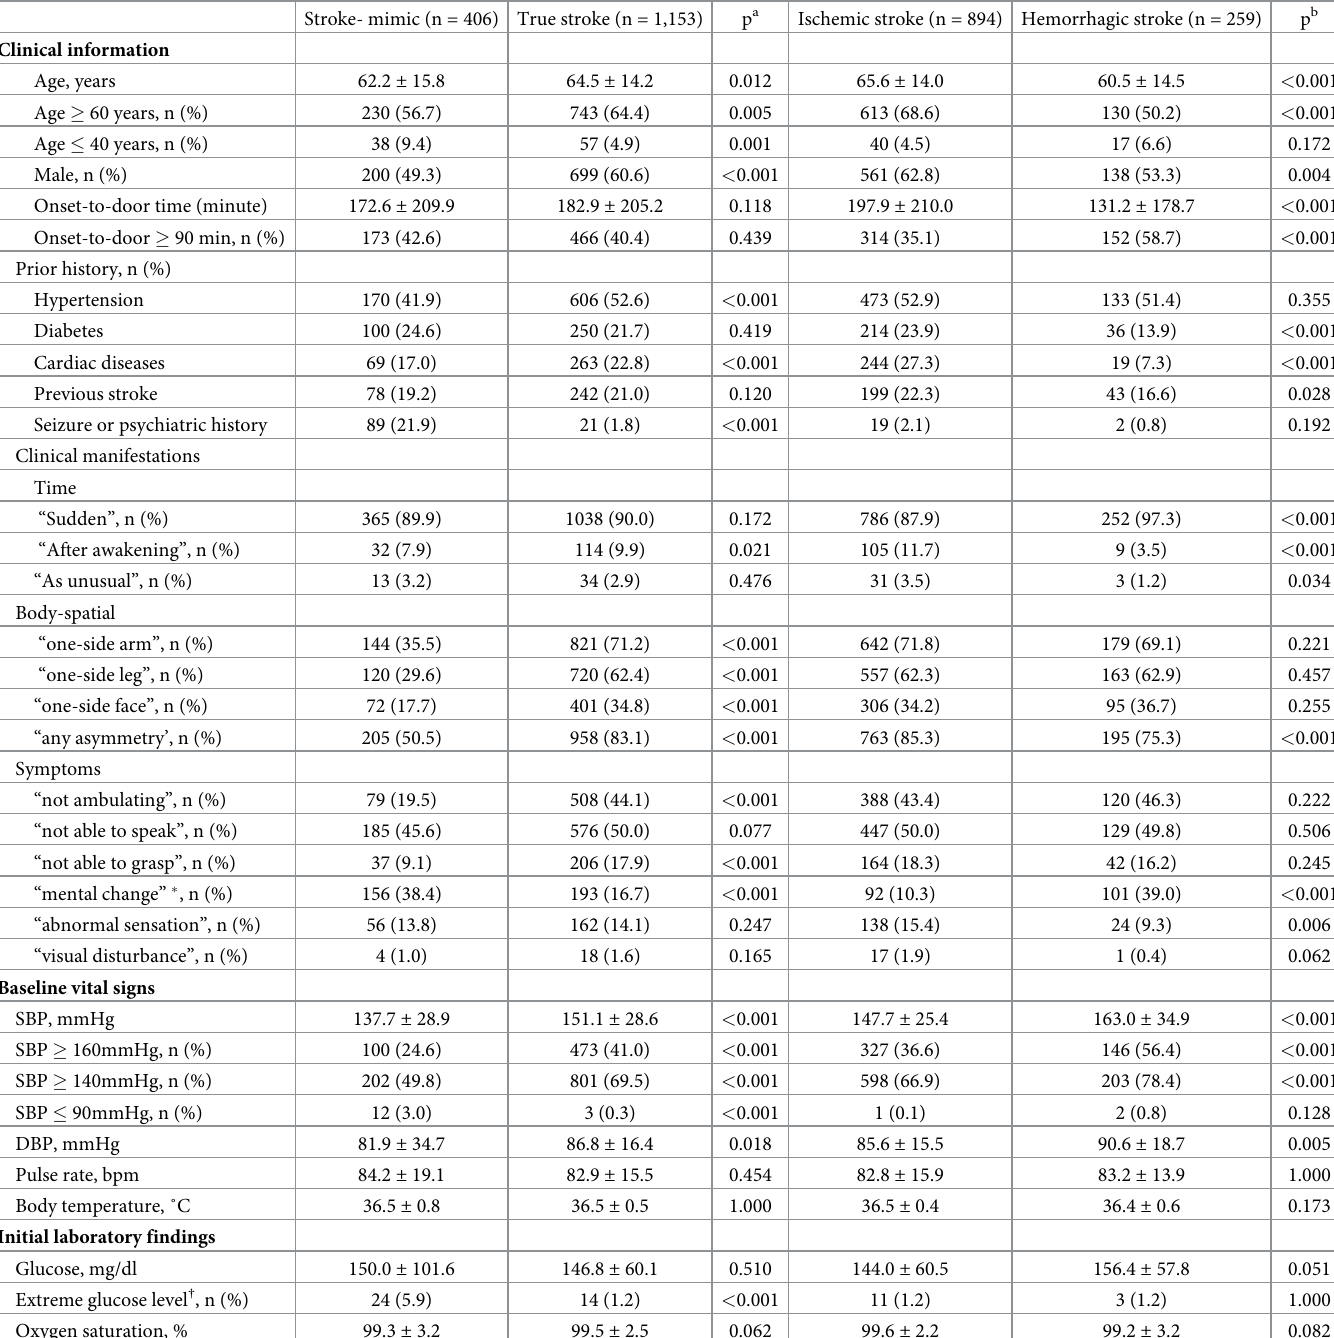
Table 1. Clinical information, vital signs, and initial labs